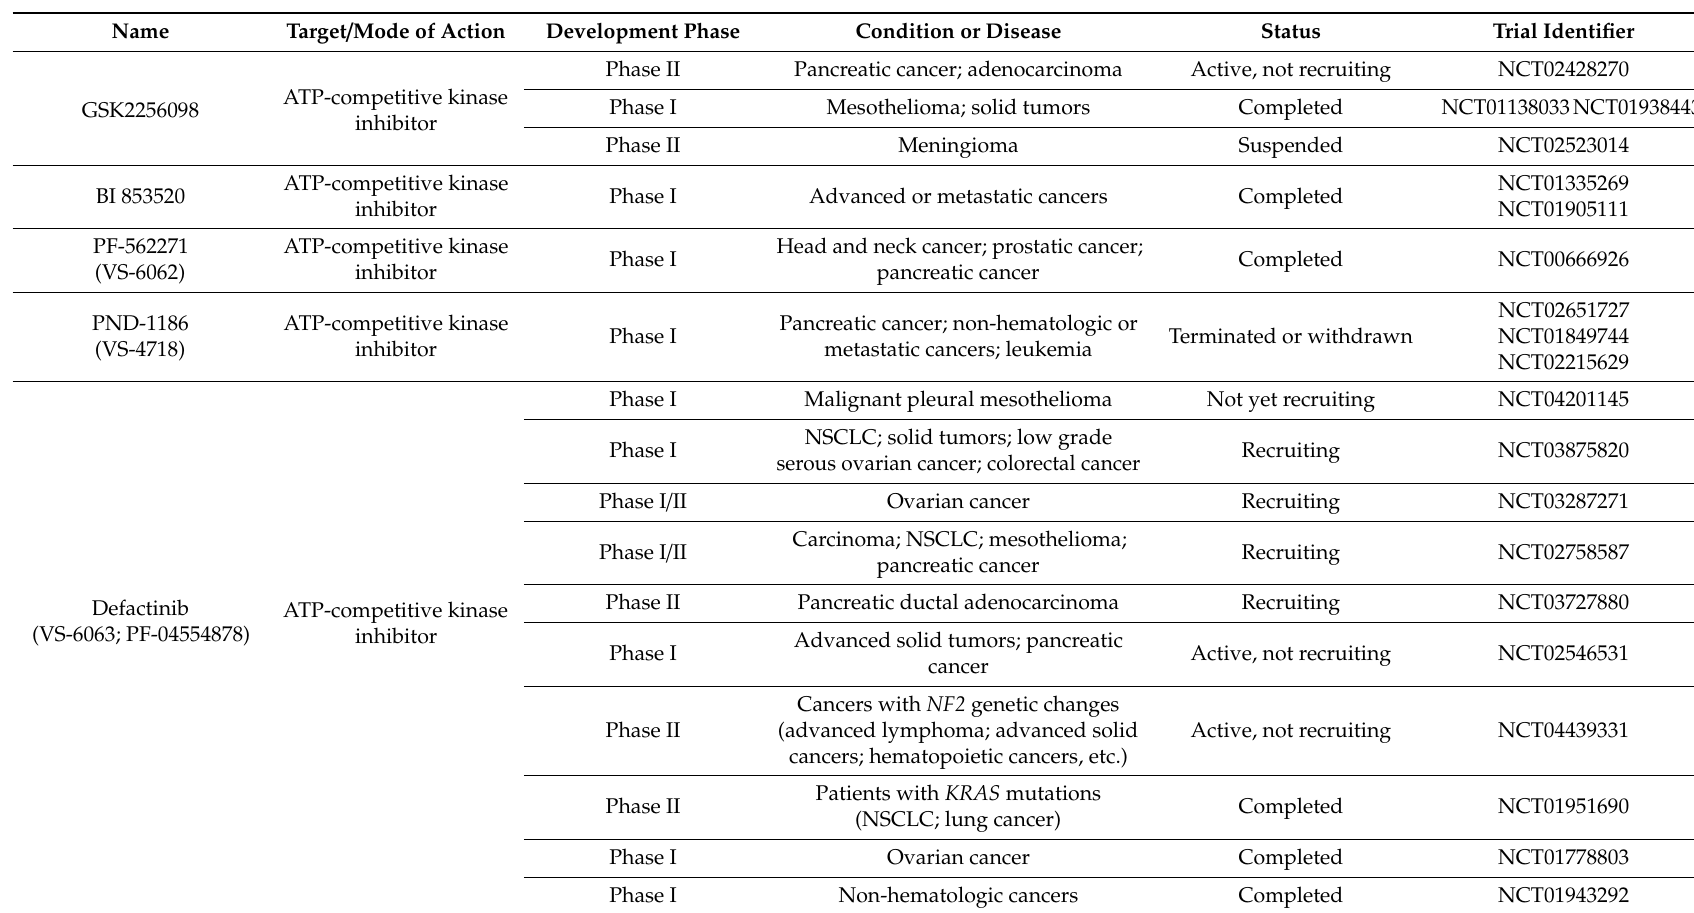
Table 2. Summary of FAK signaling inhibitors in clinical